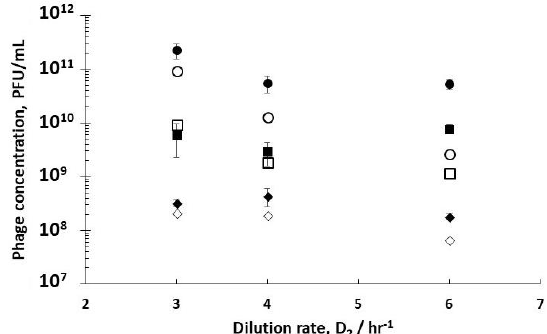
Figure 7. Simulation results showing modelling fit of final phage titres in reactor R3 using output conditions from reactor R2 as inlet conditions for the semi-batch operation of R3. Filled squares ( ■ ) correspond to experimental data for phages infected in R2 when R1 was operated at D 1 = 0.4 hr −1 ; open squares (□) correspond to simulation results at D 1 = 0.4 hr −1 using a burst size of 20 and a lag time of 60 min. The inlet conditions that were used for simulations were: C 2 = 4 × 10 10 CFU L − 1 , P 2 [3.0 × 10 11 , 8.3 × 10 9 , 1.7 × 10 8 ], PFU l − 1 corresponding to D 2 [3, 4, 6], S 2 = 1.1 g L − 1 . Filled round circles ( ) correspond to experimental data for phages infected in R2 when R1 was operated at D 1 = 0.5 hr − 1 ; open round circles (o) correspond to simulation results at D 1 = 0.5 hr − 1 using a burst size of 100 and a lag time of 60 min. The inlet conditions that were used for simulations were: C 2 = 1 × 10 10 CFU L − 1 , P 2 [3.8 × 10 11 , 2.6 × 10 10 , 2.1 × 10 9 ], PFU l − 1 corresponding to D 2 [3, 4, 6], S 2 = 1.5 g L − 1 . Filled diamonds ( (cid:7) ) correspond to experimental data for phages infected in R2 when R1 was operated at D 1 = 0.6 hr − 1 ; open diamonds ( ♦ ) correspond to simulation results at D 1 = 0.6 hr − 1 using a burst size of 10 and a lag time of 60 min. The inlet conditions that were used for simulations were: C 2 = 3.7 × 10 9 CFU L − 1 , P 2 [1 × 10 10 , 8 × 10 9 , 7 × 10 7 ], PFU l − 1 corresponding to D 2 [3, 4, 6], S 2 = 2.3 g L − 1 . The other simulation parameters that were used for all of the simulations were: δ = 3.6 × 10 − 9 L hr − 1 , and the semi-batch reactor inlet flow rate that was used was 0.25 L hr − 1